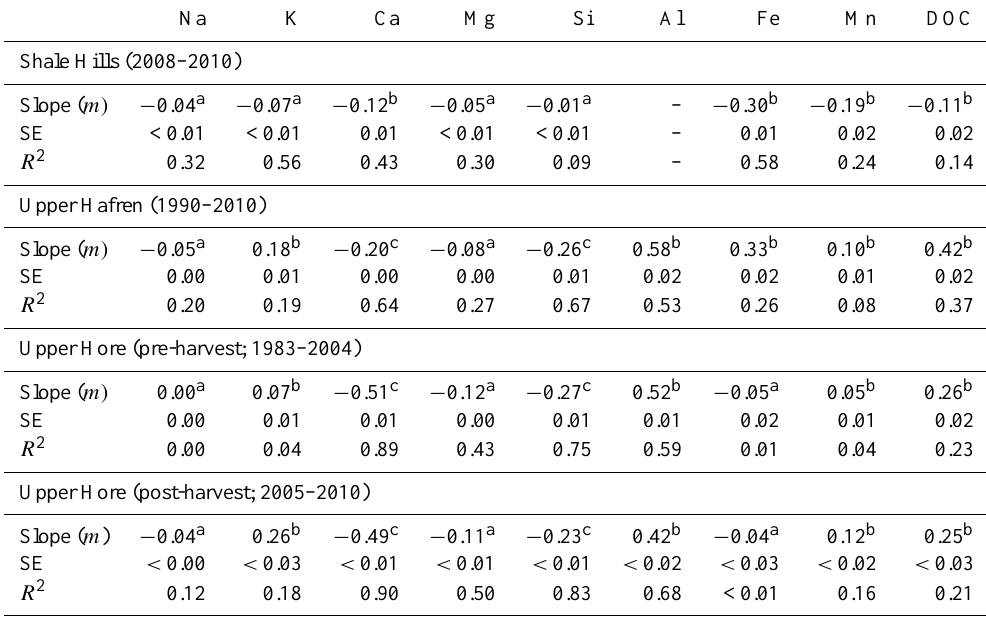
Table 4. Slopes of regression lines fit to C – Q data (log C = a + m × log Q ) indicate chemostatic a , non-chemostatic b , or dilution c concentration–discharge